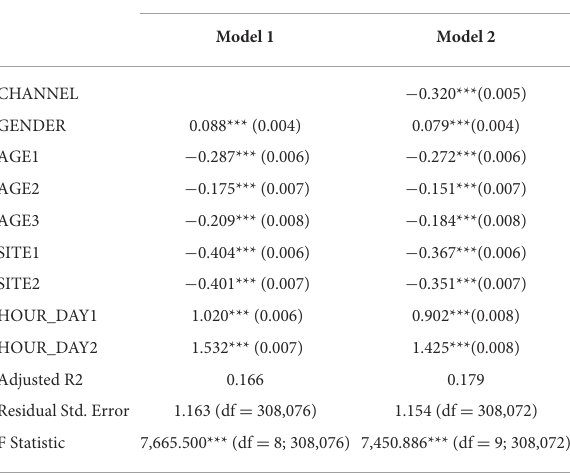
TABLE 5 Results for appointment channel-patient’s waiting